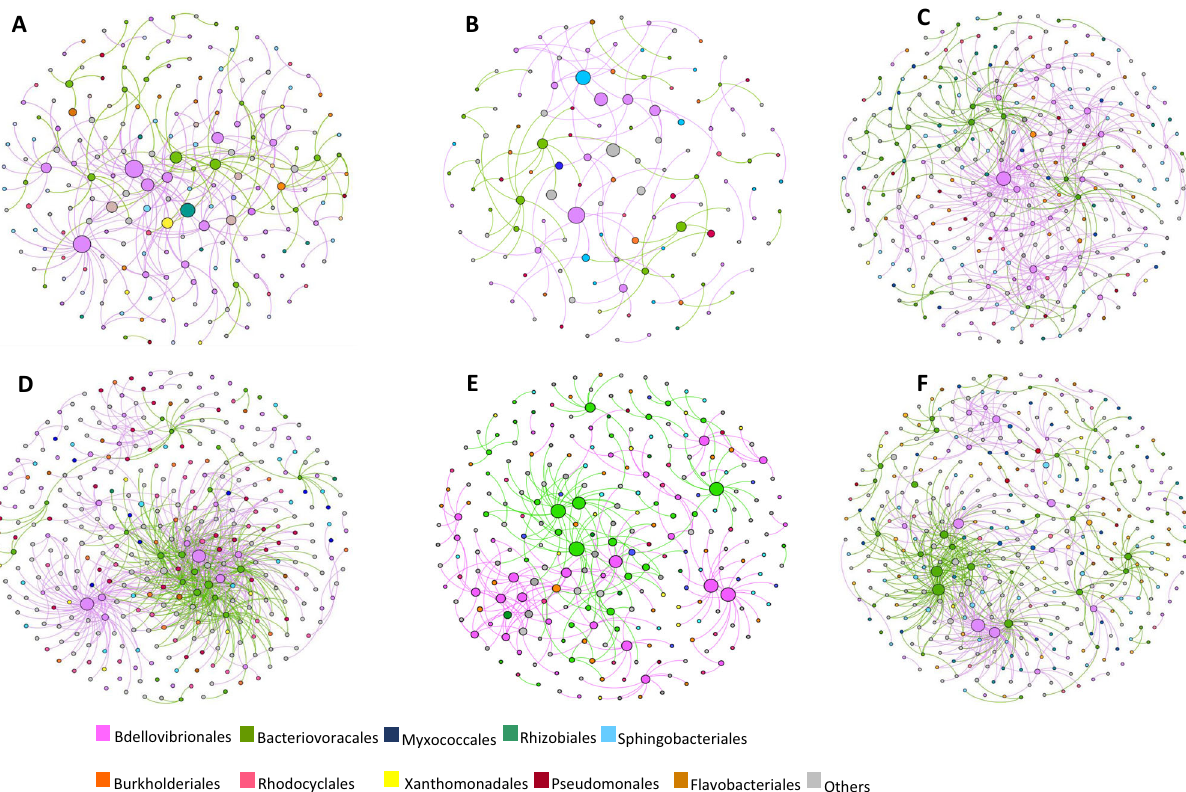
Fig. 5 Network analysis of BALO predator – prey interactions. At the Shafdan ( A , B ), Al-Bireh ( C , D ) and Langenreichenbach ( E , F ) WWTPs in the fl oc ( A , C , E ) and liquor ( B , D , F ) fractions. Connections stand for strong negative (Kendall τ < -0.7) and signi fi cant ( p < 0.05) correlations. The size of each node is proportional to the number of connections (i.e. the number of prey OTUs that the predator is connected